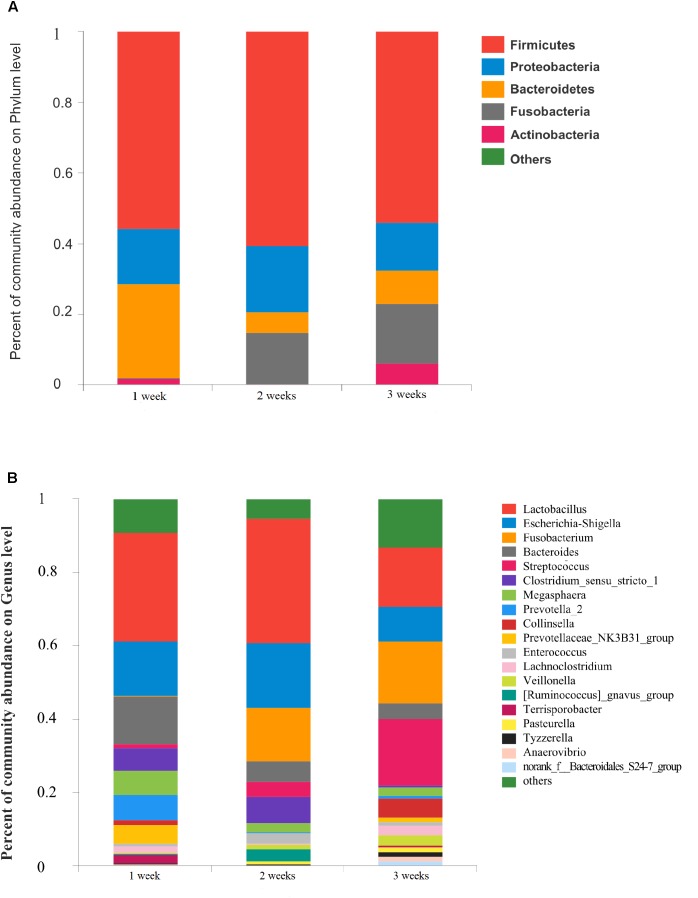
Community bar-plot analysis shows relative abundance of sequences at (A) phylum and (B) genus levels in the three age groups. OTUs comprising less than 1% of the total abundance at both phylum and genus level are represented.